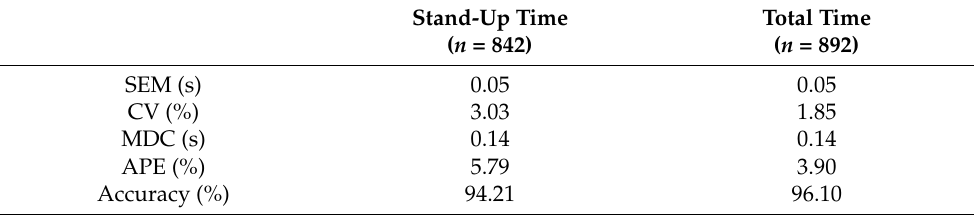
Table 3. Absolute reliability and accuracy inter-devices.